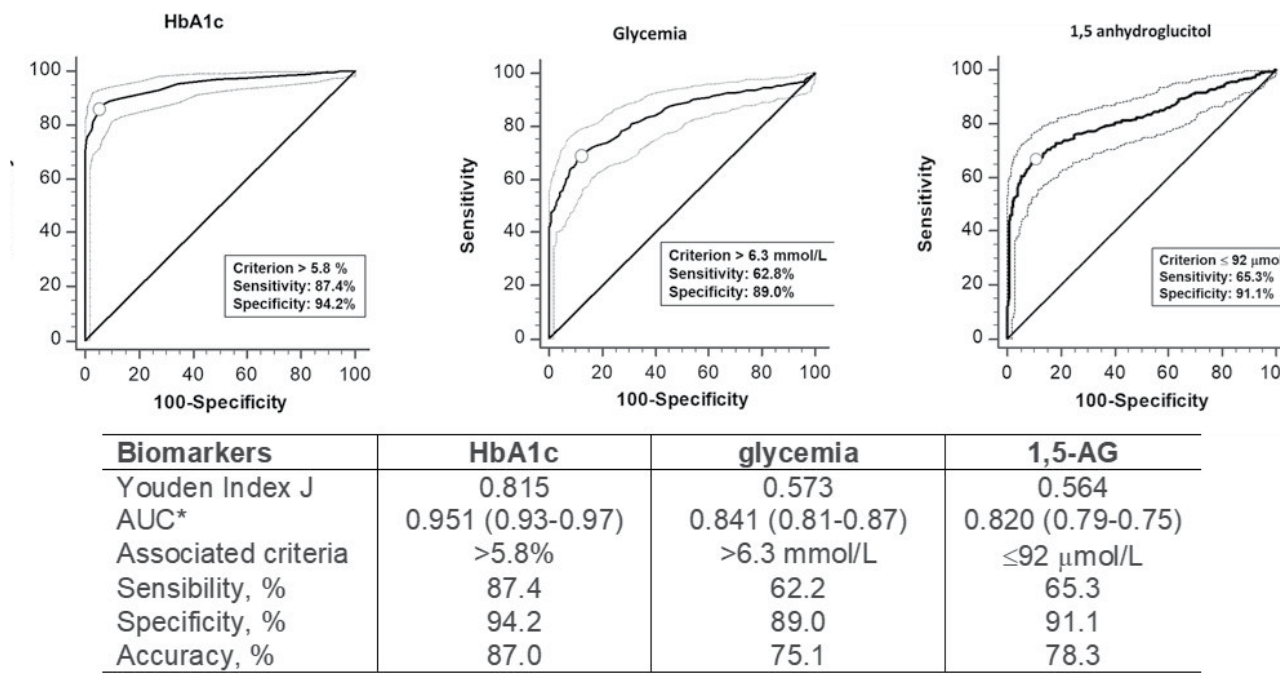
FIGURE 1 – ROC (receiver operating characteristic) for the glycemic biomarkers HbA1c, glycemia, and 1,5-anhydroglucitol (1,5-AG). The circle indicates the cut-off point (associated criteria) and the dashed lines in the curve indicate the 95% CI. The table under the figure describes the relevant index. *AUC, area under the curve, all areas showed P<0.001. Positive predictive value (%)/Negative predictive value (%) for HbA1c (93.2/82.2), glycemia (85.4/74.4) and 1,5-AG